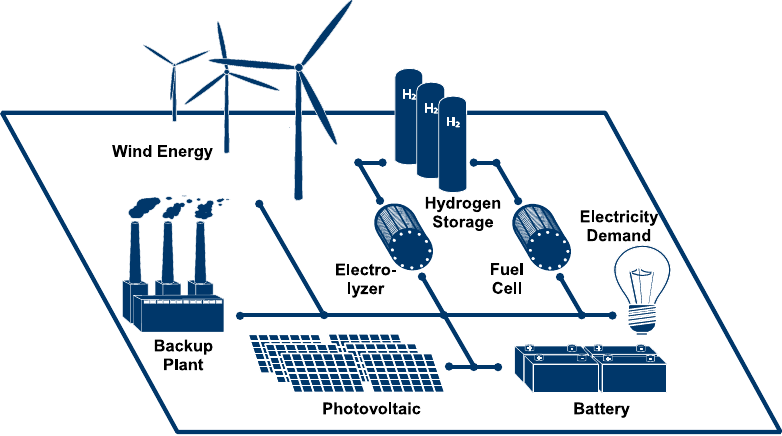
Figure 11. Technology portfolio of the island system.